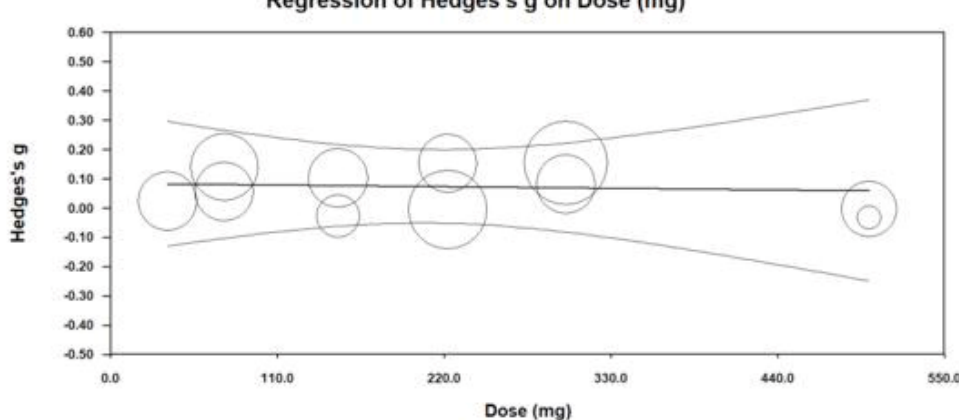
Figure 5. Meta-regression of the association between the guarana dose and the overall study ES. Circles indicate individual studies, with the circle size indicating the relative study weight. Curved lines indicate a 95 percent confidence interval.